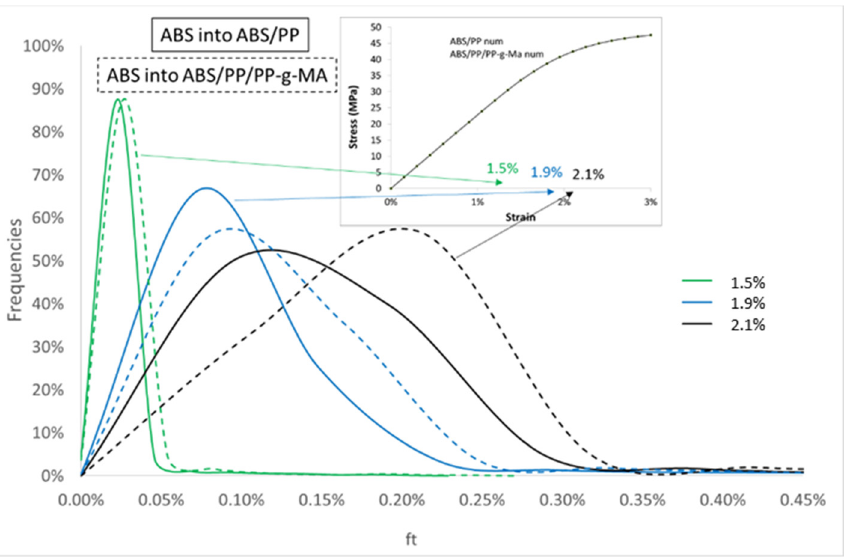
Figure 21. Frequencies of elements versus effective porosity fraction (see Equation (4)) for several macroscopic strains for ABS into ABS/PP and ABS/PP/PP-g-MA composites.